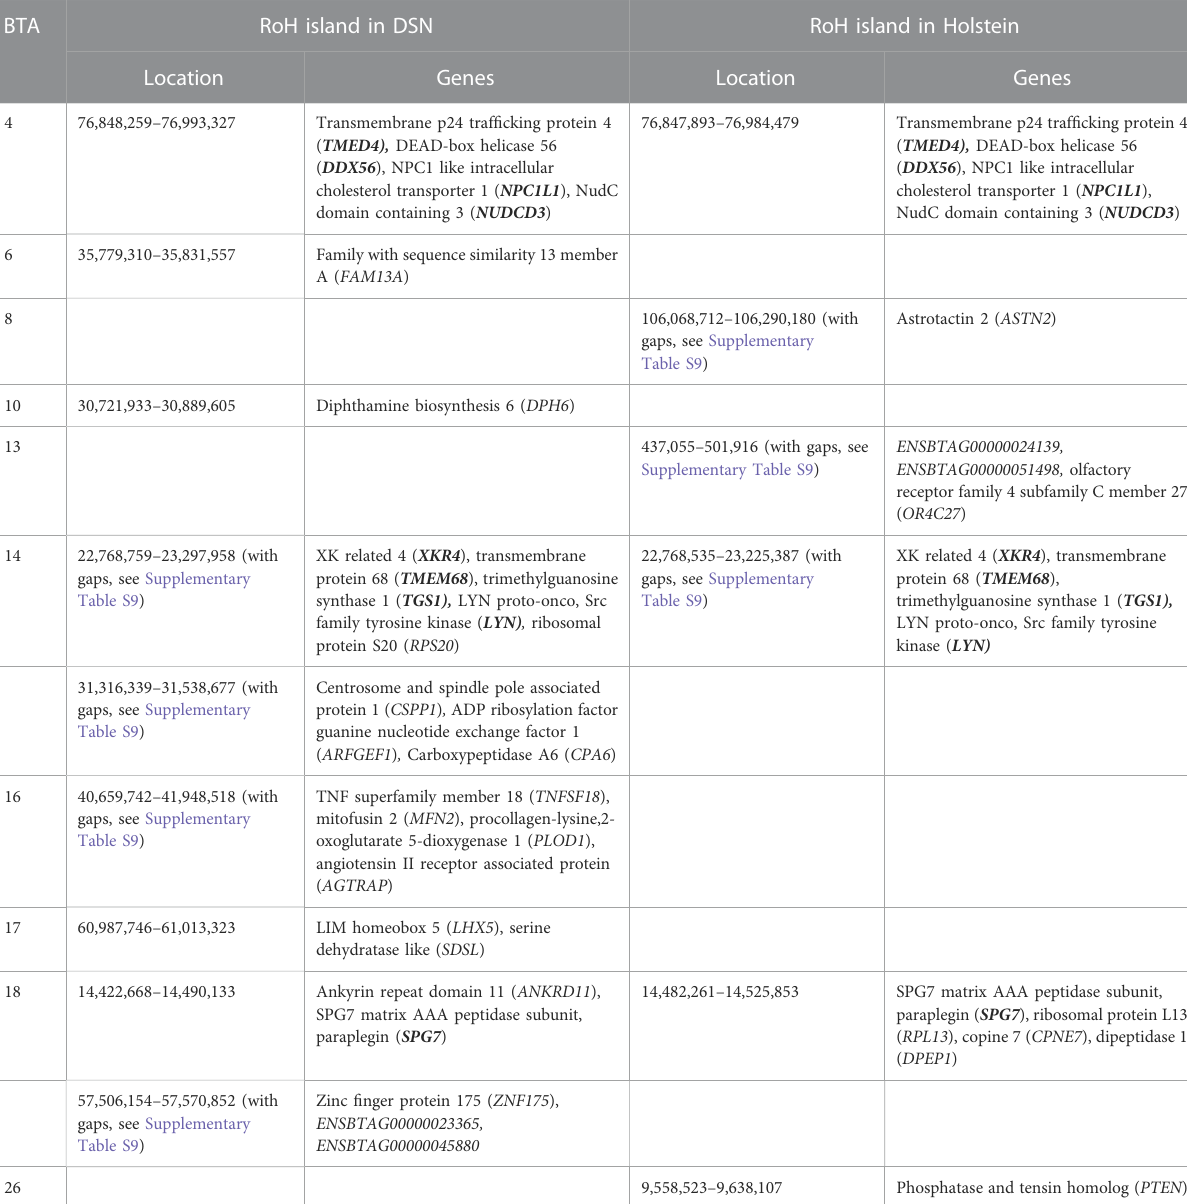
TABLE 4 Location of RoH islands and genes inside RoH islands in DSN and in Holstein. Genes in bold are common between breeds. BTA RoH island in DSN RoH island in Holstein Location